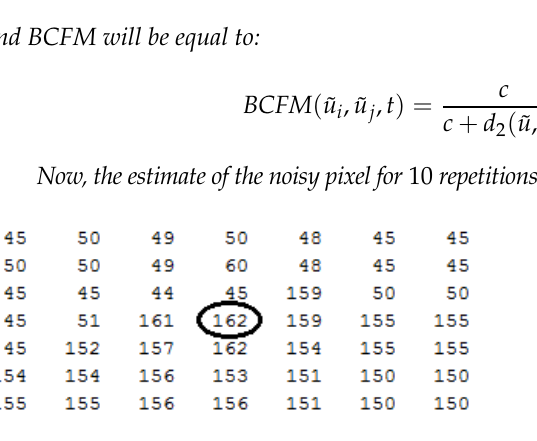
Figure 10. Image matrix after noise